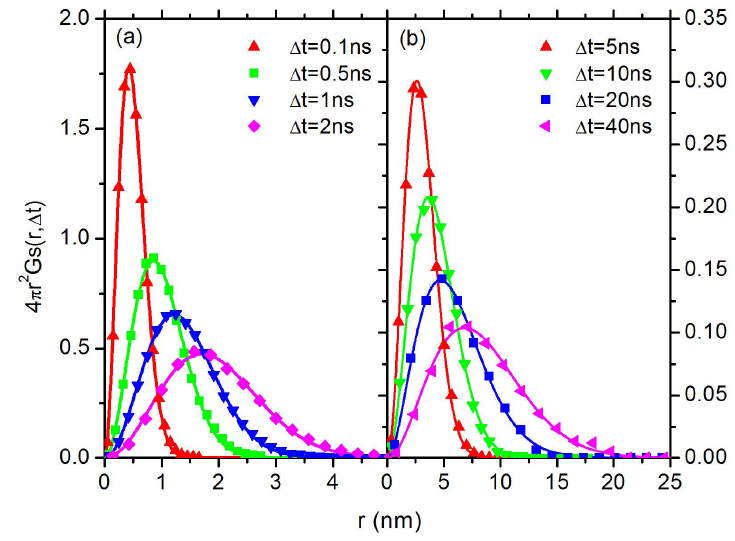
Figure 6. The DDF, 4 π r 2 G s ( r , ∆ t ) , for C 60 in PP melt at different time scales (symbols): ( a ) the results of C 60 in the subdiffusive regime at short time scale; and ( b ) the results of C 60 in the normal diffusive regime at long time scale. The solid lines represent the corresponding